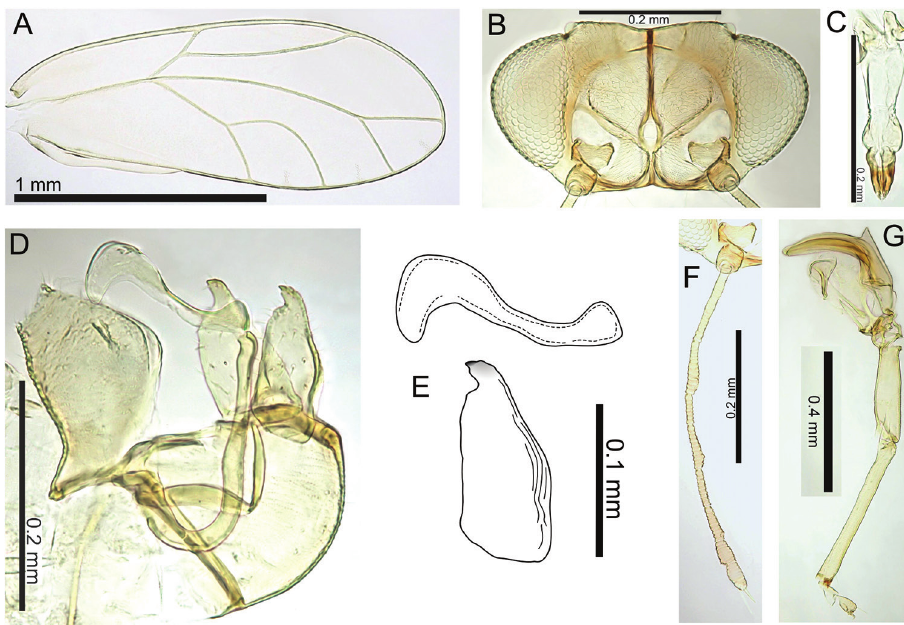
Figure 30. Pariaconus haumea sp. n. A fore wing B head C proboscis D male terminalia E aedeagus and paramere F antenna G hind